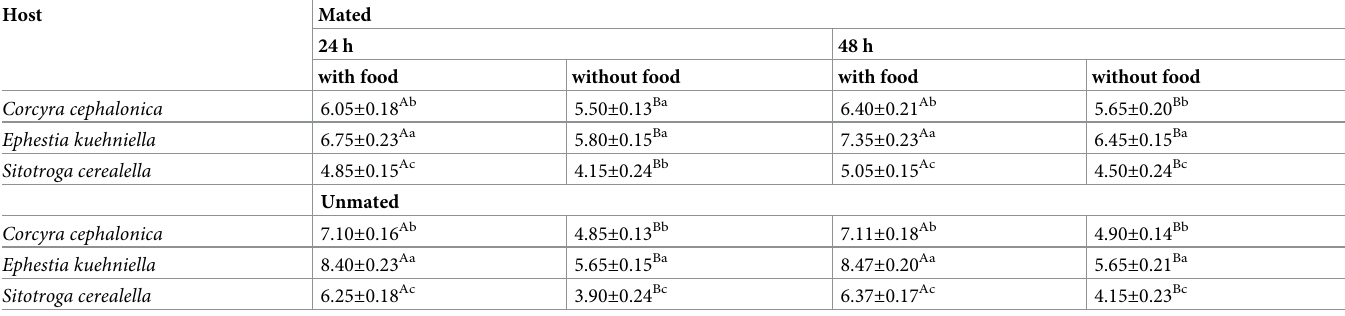
Table 2. The longevity (days) of emerged Trichogramma japonicum when host eggs were exposed to mated and unmated female parasitoids for 24 and 48 h under with and without food conditions. Honey was used as a food source for adult parasitoids. Host Mated 24 h 48 h with food without food with food without food Corcyra cephalonica Ephestia kuehniella Sitotroga cerealella Corcyra cephalonica Ephestia kuehniella Sitotroga cerealella Capital letters within rows, lowercase letters within columns with the same letter after the Means ± SE within each exposure period did not differ significantly as per one- way ANOVA and Student’s t -test ( P < 0.01),